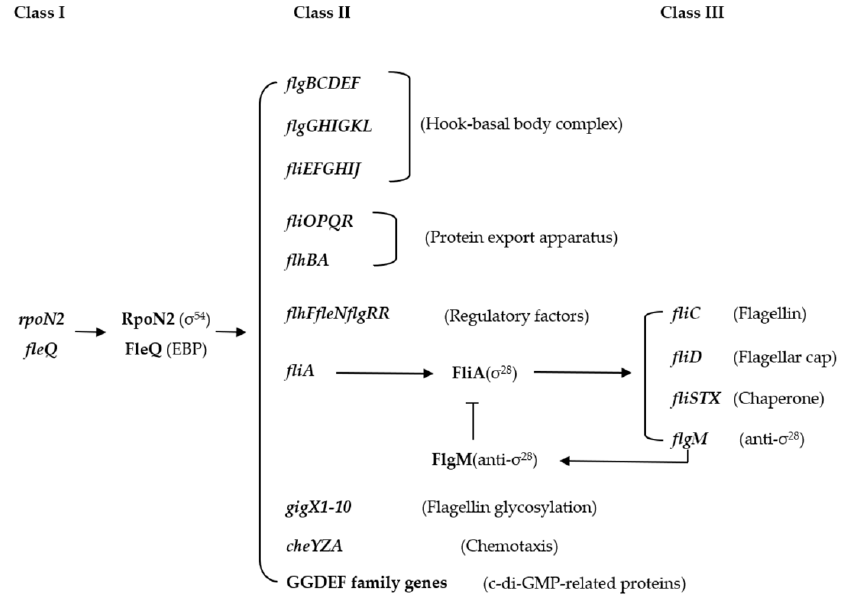
Figure 3. The three-tiered hierarchy of flagella synthesis in Xoo . The RpoN2 and FleQ, encoded by the class I genes rpoN2 and fleQ , are the master regulators and control the transcription of class II genes. The class II gene products include most of flagellum structural components, regulatory factors (FlhF, FleN and FlgRR), flagellin glycosylation-related proteins (GigX1-10), chemotaxis-related proteins (CheYZA), c-di-GMP synthesis and degradation related proteins, and alternative sigma factor FliA. FliA regulates the transcription of class III genes, which encode the flagellin FliC, the flagellar cap FliD, the flagellar chaperone proteins FliS and FliTX, and the anti- σ 28 factor FlgM. Interestingly, FlgM negatively regulates FliA activity and protects it from degradation.